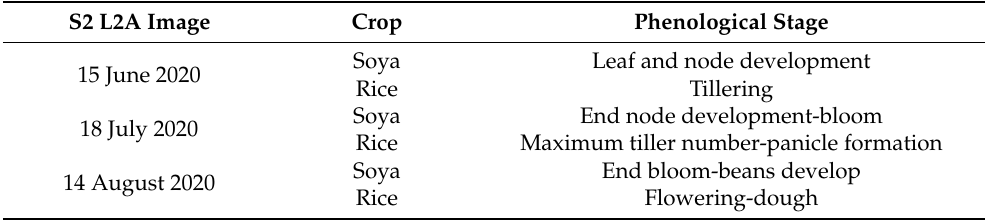
Table 3. S2 images and corresponding phenological stage of rice and soya